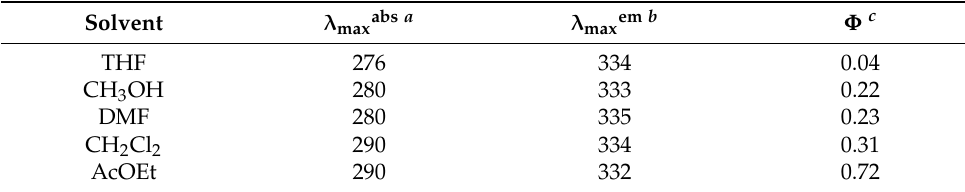
Table 2. Optical property of NP(Fl) in organic solvents.